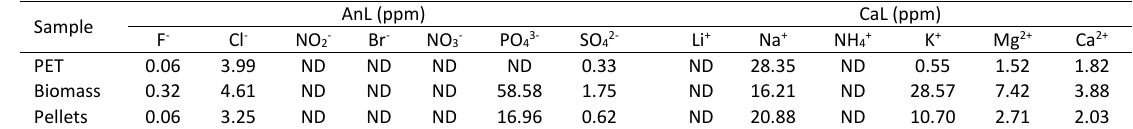
Table 4: The results of anionic and cationic leachability